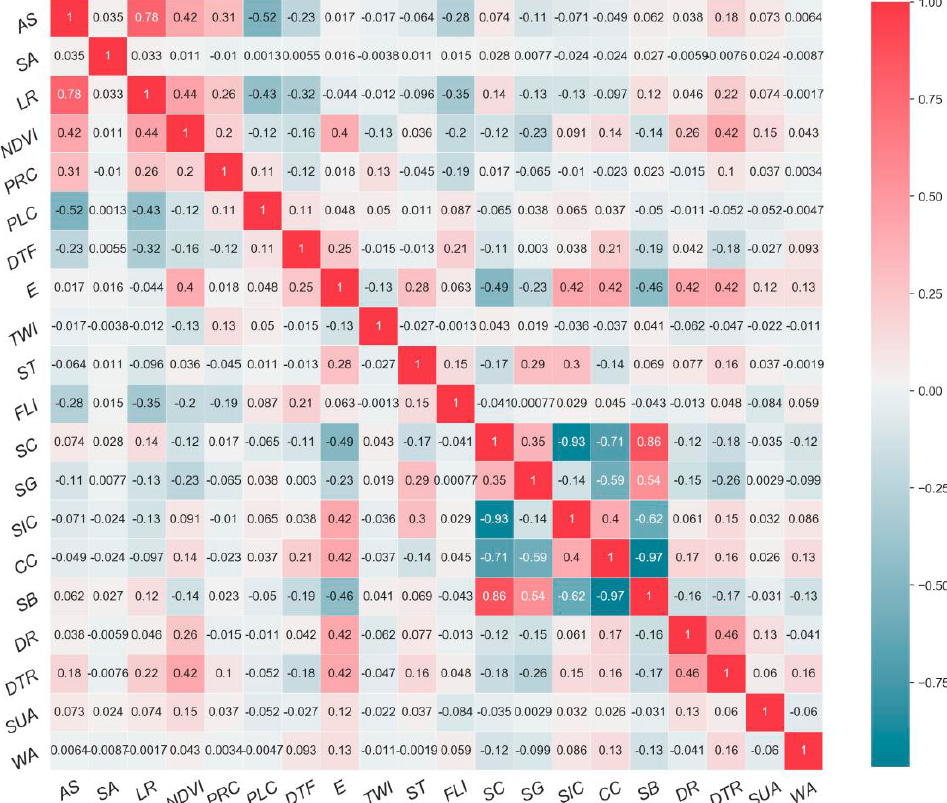
Figure 5. Heat map of the parameter correlation matrix.